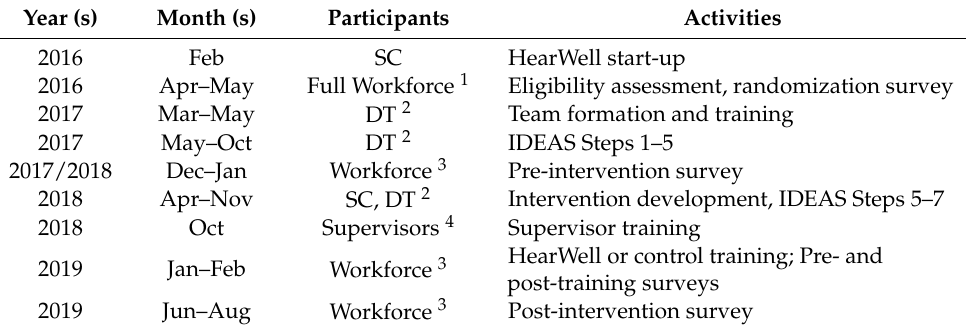
Table 1. HearWell Study period timeline and major